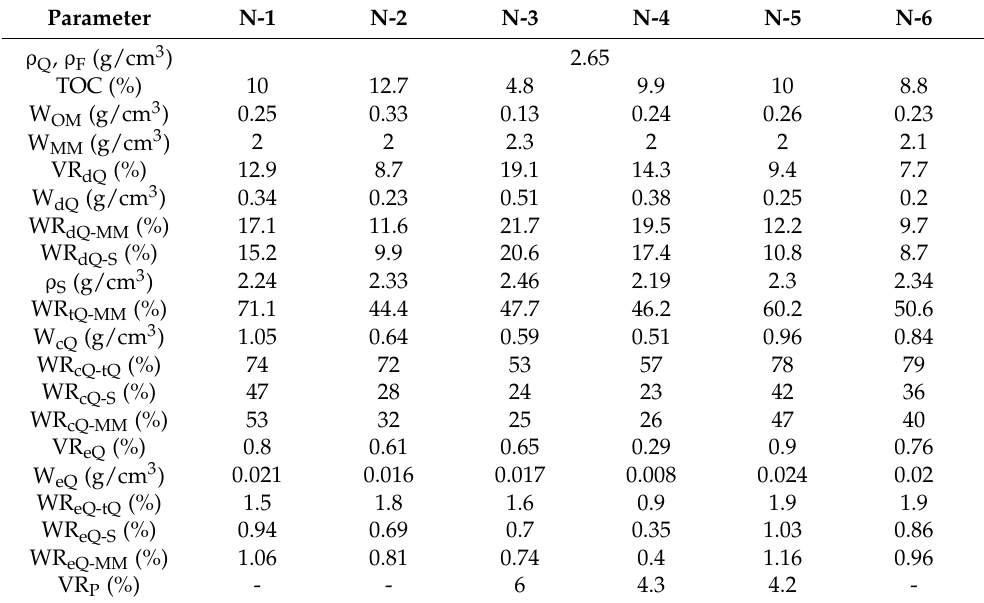
Table 5. Content calculation results for clay-sized, “elongated” quartz and volume ratio of pyroxene (see text